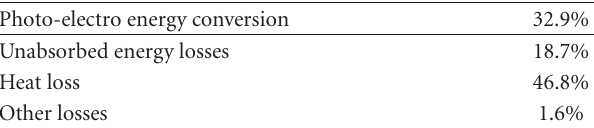
Figure 3: Change in properties of any material due to its physical size. Table 1: Various solar energy losses in single junction silicon (1.1eV energy band gap) solar cell under AM 1.5 solar spectra at 300 ◦ K temperature